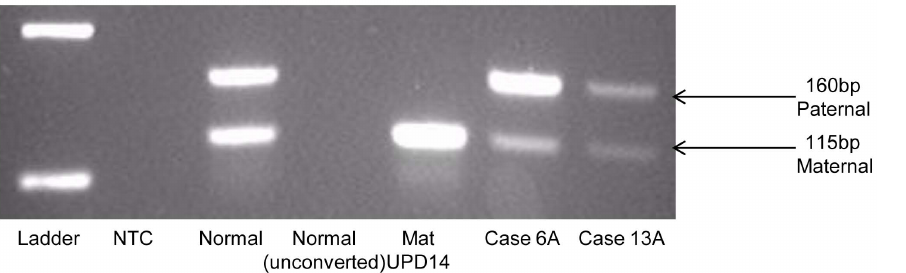
Figure 4. Loss of Maternal 14q32 Allele in Cluster B1. Agarose gel for cases in Cluster B1 showing loss of the maternal allele. Lane 1: Molecular marker, 2: NTC-no template control, 3: Normal sample, 4: Normal unconverted, 5: positive maternal UPD14, 6–7: adult mutant